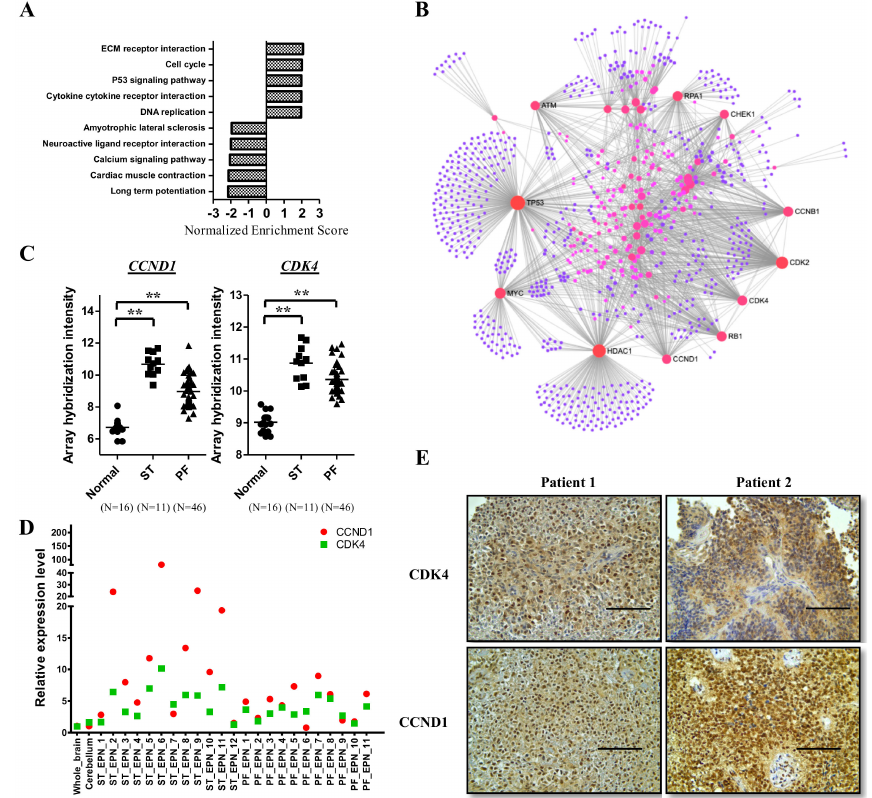
Figure 2. CDK4 and CCND1 are overexpressed in ependymomas. ( A ) Whole genes were subjected to gene set enrichment analysis (GSEA). The bar graph shows the top five upregulated and downregulated KEGG pathways in ependymomas. ( B ) The genes upregulated in the cell cycle and DNA replication were analyzed by NetworkAnalyst (https: // www.networkanalyst.ca / ). ( C – E ) Validation of CDK4 and CCND1 expression by qPCR ( D ) and IHC staining ( E ). Scale bar: 100 µ m. The array hybridization signals are also shown ( C ). ** p < 0.01. ST: supratentorial, PF: posterior fossa, also known as